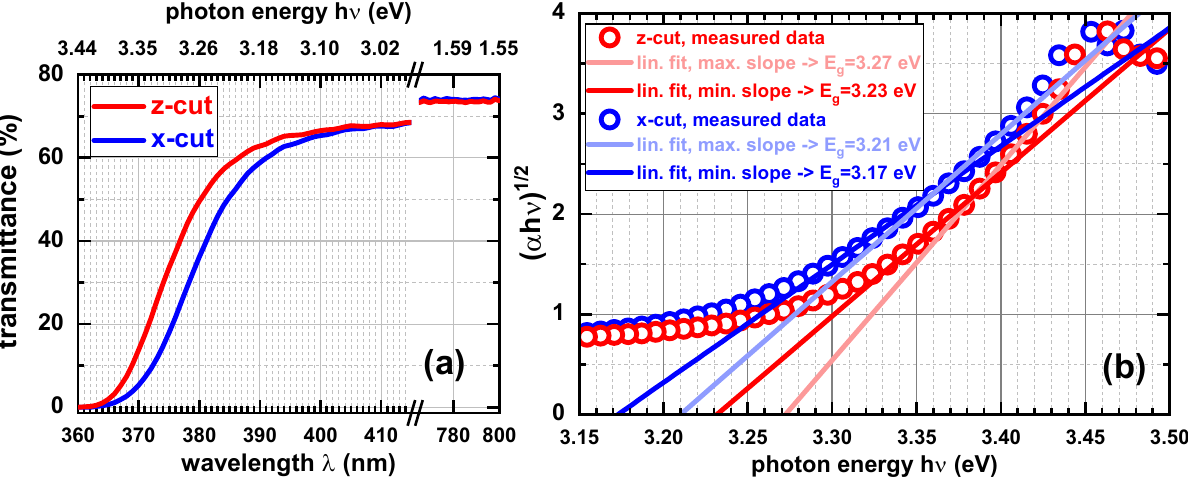
Figure 3. ( a ) Optical transmittance spectra of the x-cut and z-cut SBN61 crystals; ( b ) derivation of the respective bandgaps, which appeared to be indirect, by the Tauc method